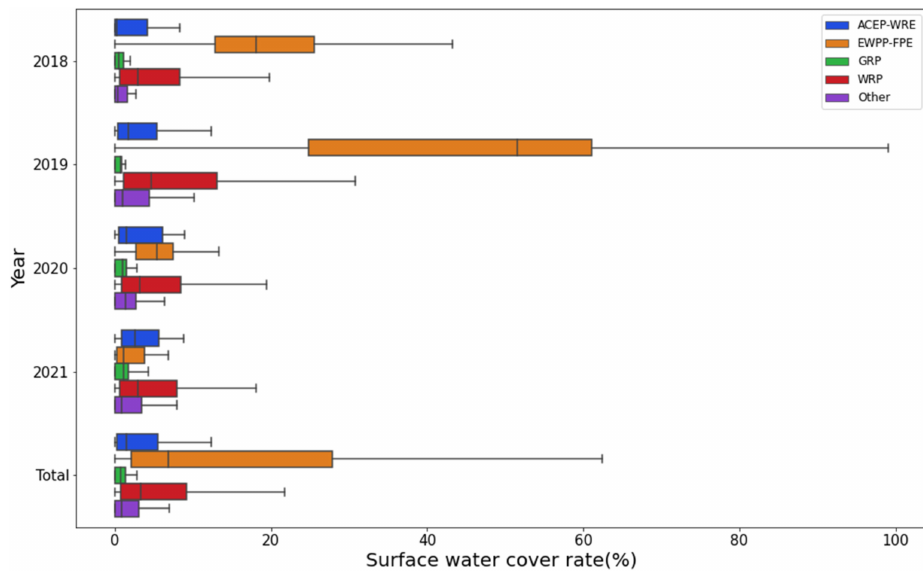
Figure 5. Surface water cover rate by area for each category of CE